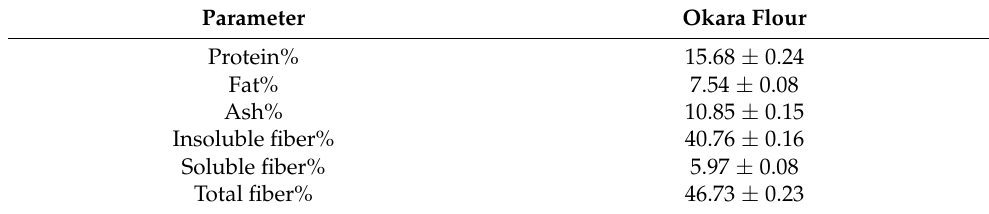
Table 1. Nutritional composition of okara